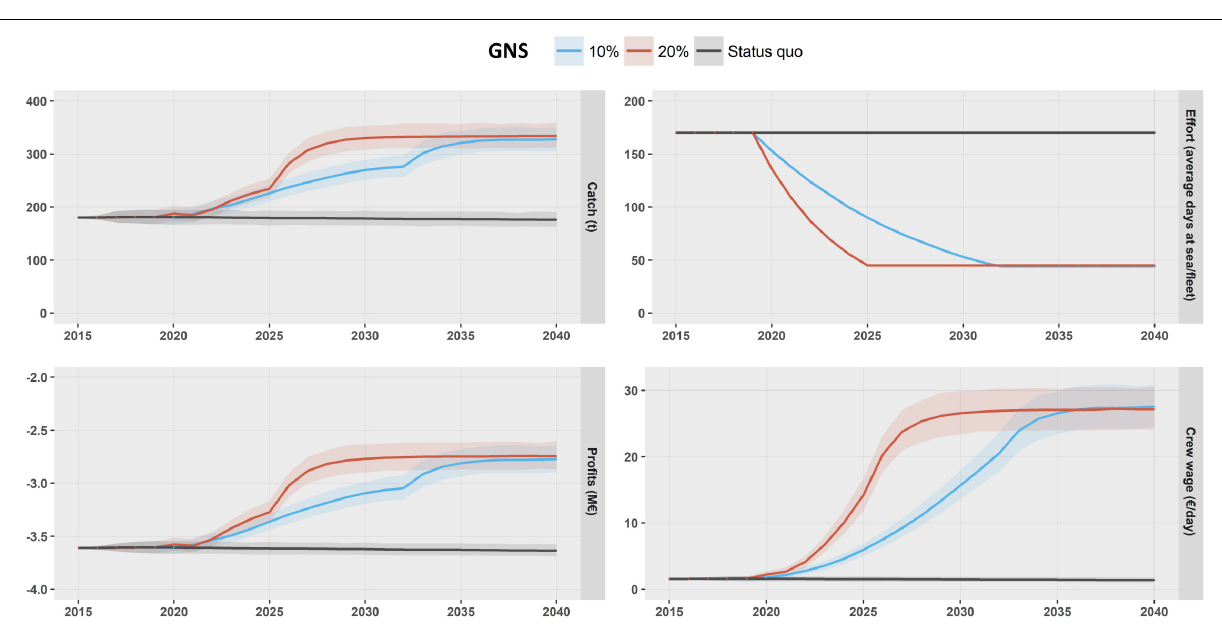
FIGURE 4 | Results of the bioeconomic model of catch (t), effort (average days at sea), profits (M€), and crew wages (€/day) for the gillnet fleet (GNS) under Scenario 0: status quo ; Scenario 1: 10% annual reduction; and Scenario 2: 20% annual